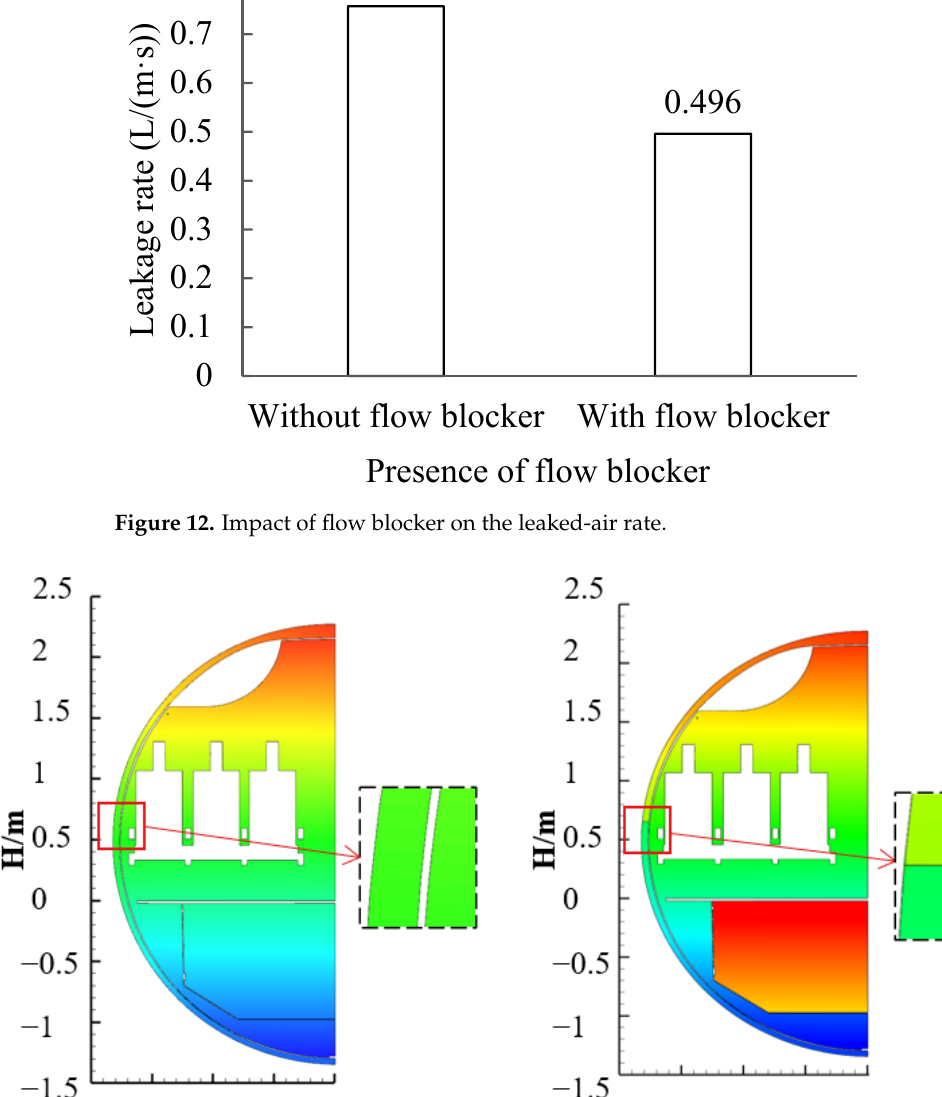
Figure 13. Pressure distribution ( a ) without and ( b ) with a flow blocker.